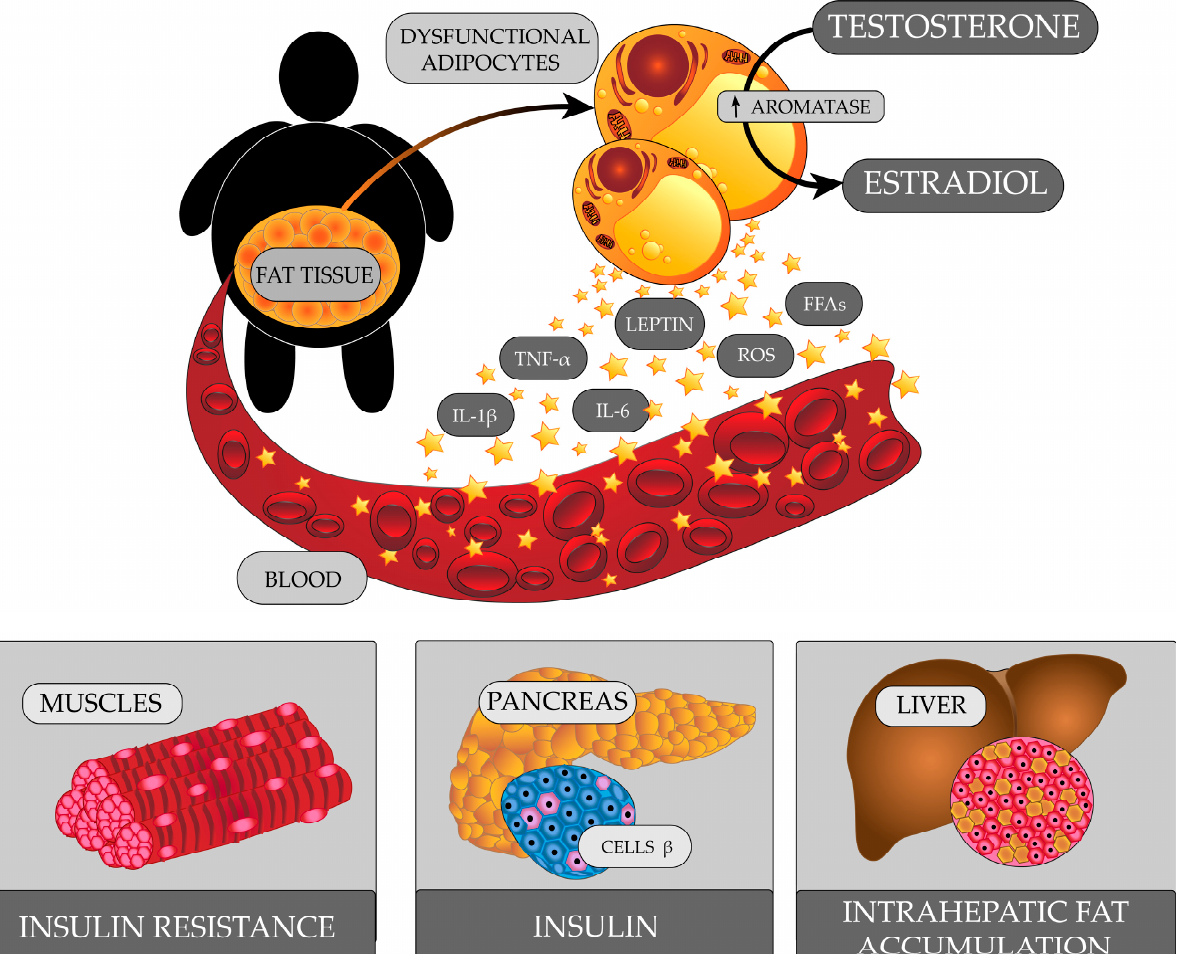
Figure 3. A diagram illustrating the factors involved in the development of HPG axis abnormalities in obese men.